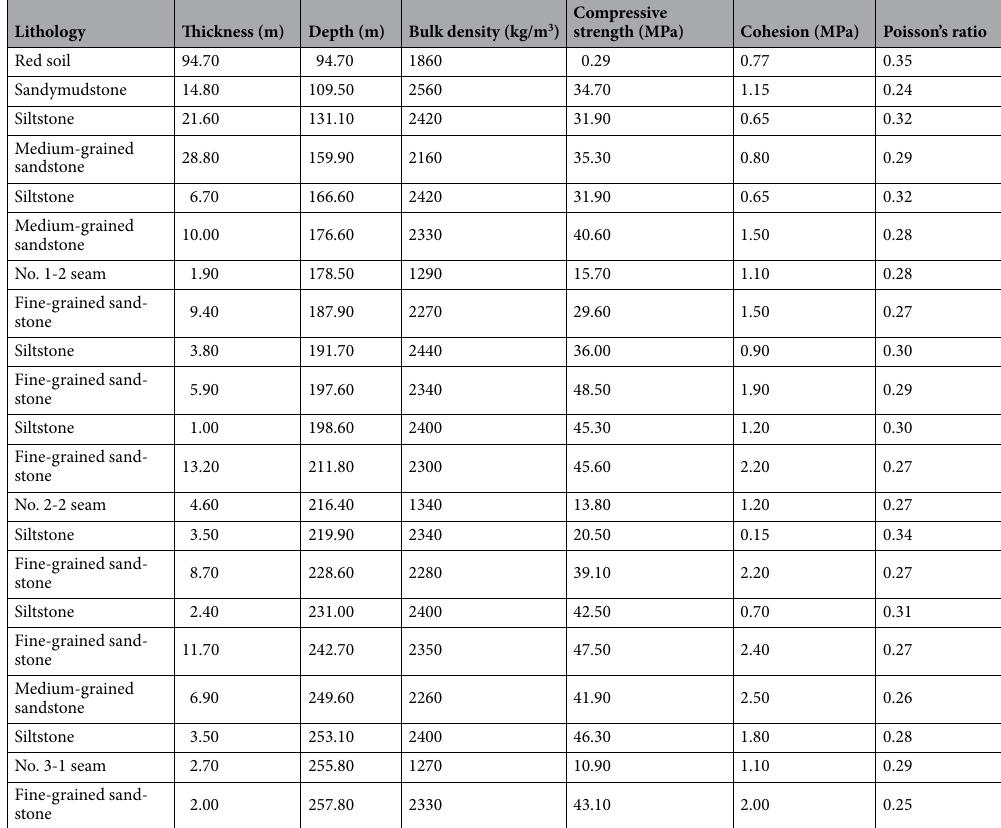
Table 1. The parameters of coal and its roof and floor.